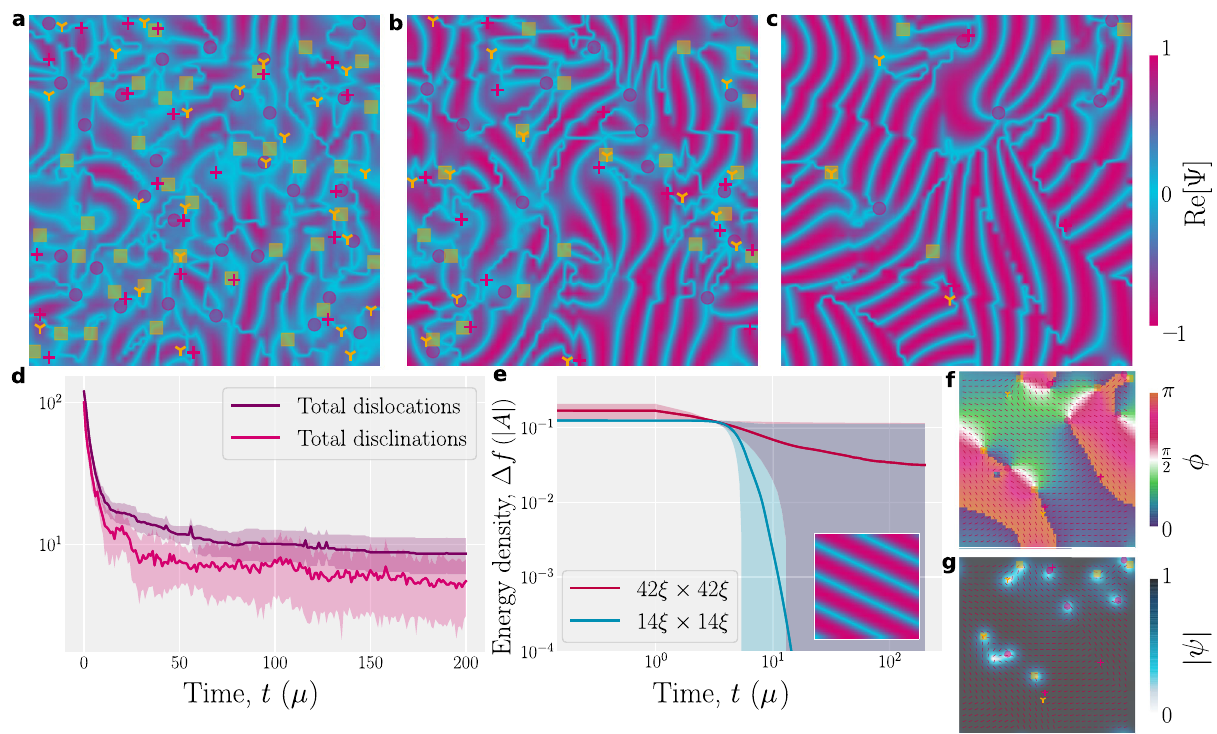
Fig.3|Deepquenchofthesimplesmecticresultsinakineticallyarrestedstate, with multiple defects. Simulations initialized from an isotropic state ( ∣ ψ ∣ ’ 0 and random N and ϕ ) with A = − 1 (lamellar state), C =2, κ 2 =0.5 and periodic boundary conditions. a – c Snapshots of Re Ψ ½ (cid:4) in a system size of 42 ξ ×42 ξ at times a t =2 μ ; b 5 μ ;and c long-timelimitkineticallyarrestedstate(snapshotattime t =20 μ ).Pink crosses (yellow trilaterals) mark+1/2 ( − 1/2) disclinations. Edge dislocations with